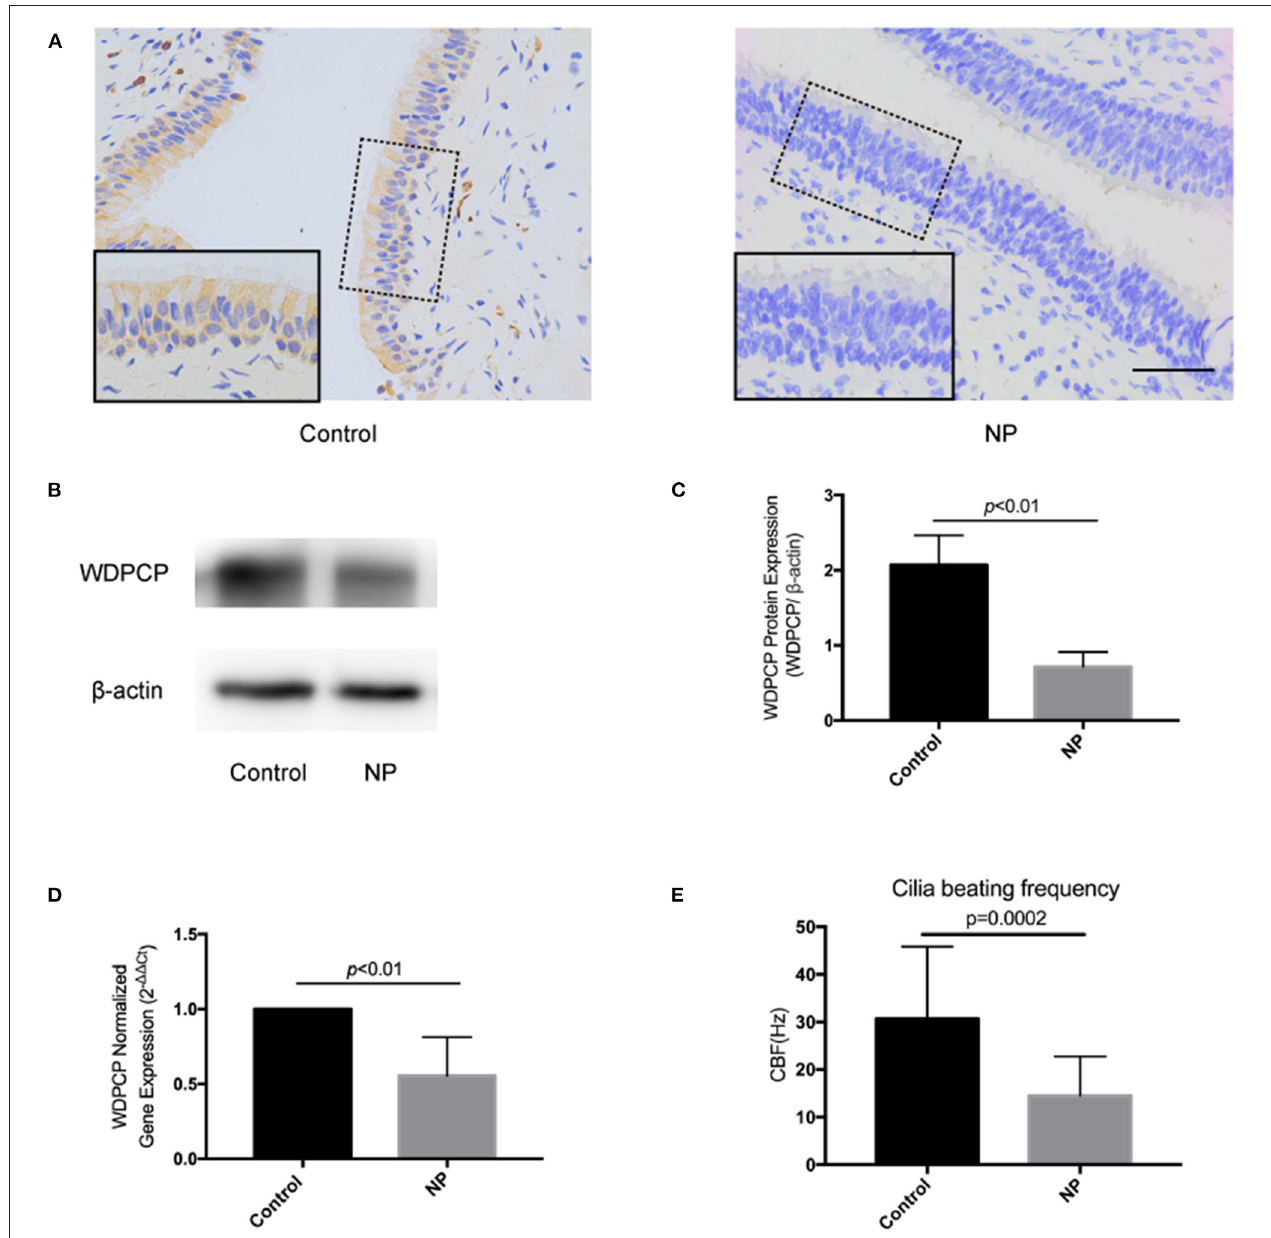
FIGURE 1 | Epithelium of nasal polyps demonstrated a low expression of WDPCP and had decreased cilia beating frequency compared with control subjects. (A) The expression of WDPCP in the cytoplasm of epithelial cells from nasal polyps (NP) was decreased as determined by immunohistochemical staining (brown color). Scale bar: 50 µ m. (B,C) Western blot images and densitometry showed decreased WDPCP protein levels in NP compared with nasal mucosa from control subjects ( n = 3). (D) The copy number of WDPCP mRNA was decreased in NP ( n = 3). (E) Cilia beating frequency (CBF) was significantly reduced in NP compared with control mucosa ( n =